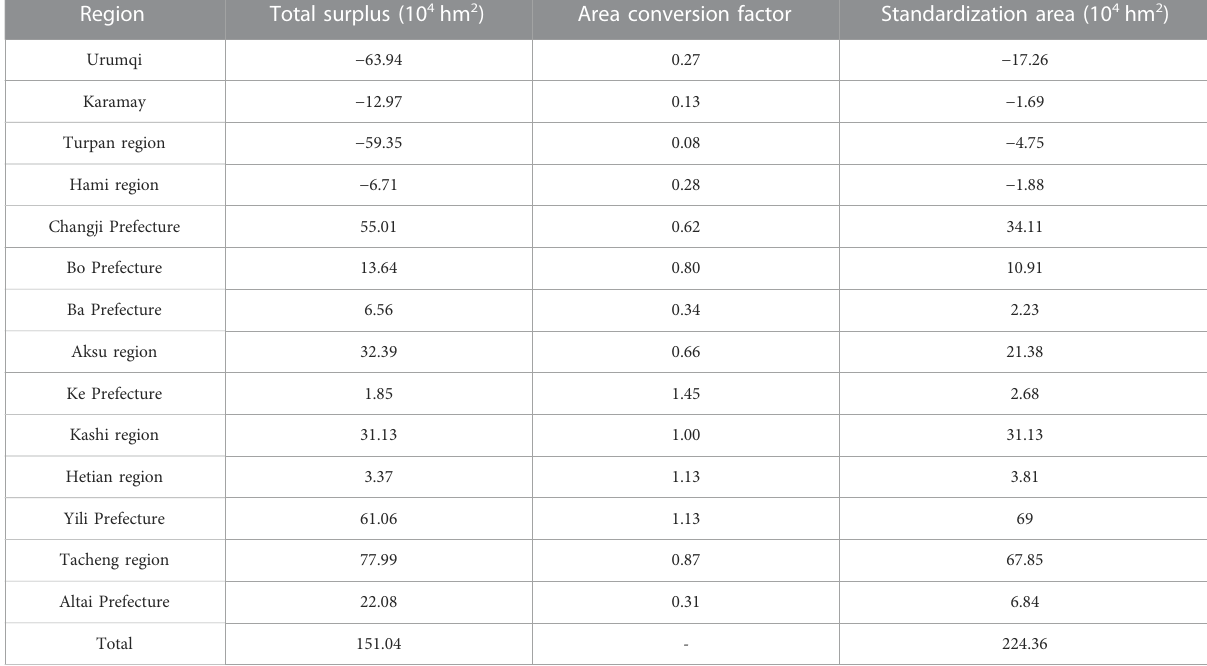
TABLE 1 State (city)-cultivated land surplus/de fi